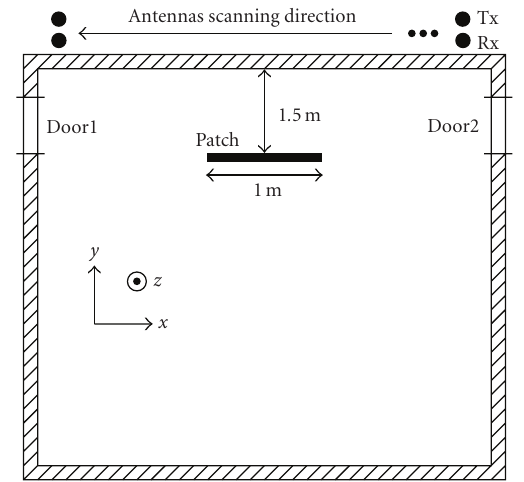
Figure 21: Considered configuration for the TWRI test.